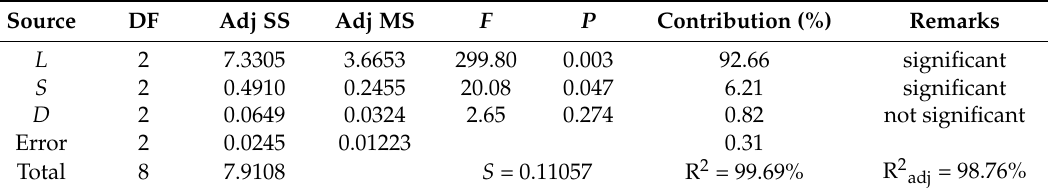
Table 5. ANOVA for S/N ratio of µ .